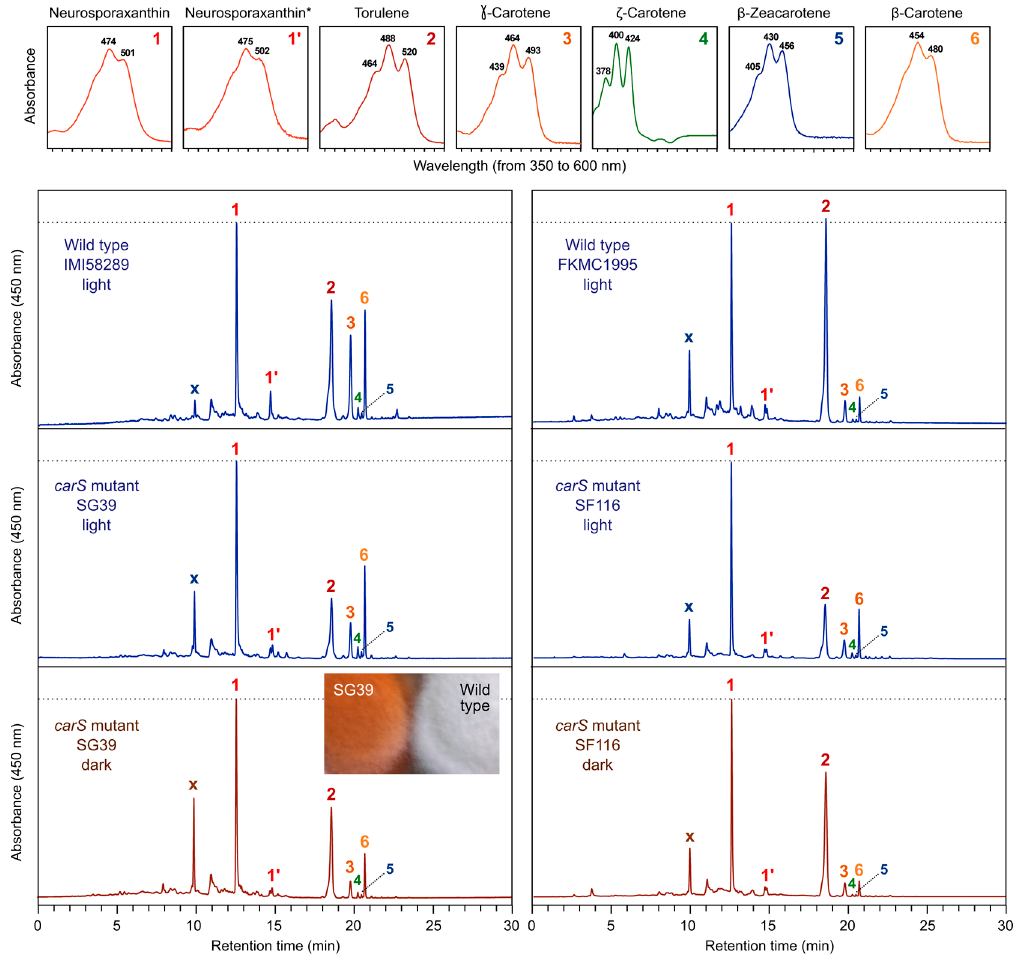
Figure 4. HPLC analysis of carotenoids produced by two different wild types of F. fujikuroi and the carS mutants SG39 [22] and SF116 [48]. The strains were grown for 7 days on DG minimal medium in the dark or under light (7 W m − 2 white light). The method for HPLC separation has been described [75]. In brief, the samples were run in a reverse-phase C18 column with a binary-gradient elution (acetone : deionized water) at a flow rate of 1 mL/min. Detection was performed at 450 nm and online UV/Visible absorption spectra were acquired in the wavelength range 350–600 nm. The UV/Visible spectra of the identified carotenoids are shown above. The peak X corresponds to an unknown carotenoid with maximal absorbance at 480 nm, whose identity is under investigation. The peak 1’ is assigned as a neurosporaxanthin isomer. Phytofluene cannot be detected at 450 nm, but traces of this carotene were detected at 368 nm (data not shown). The inner picture shows the pigmentation of 7-day old colonies of the wild strain IMI58289 and the carS mutant SG39 grown on minimal DG medium in the dark.